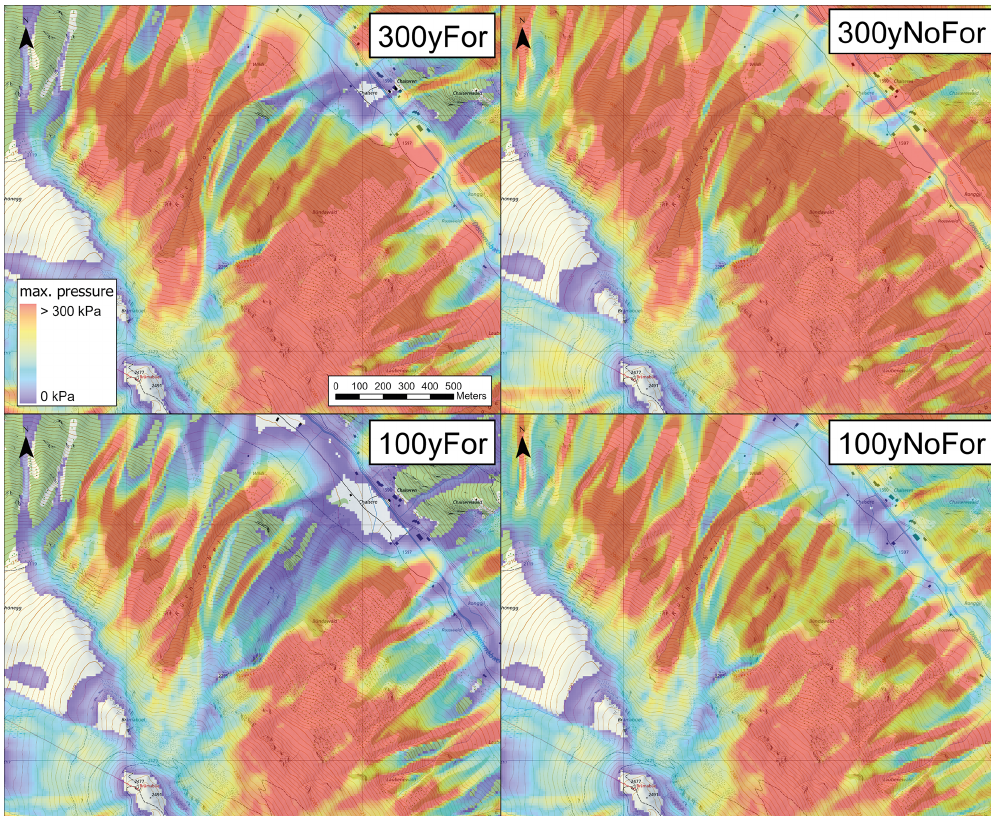
Figure 8. Maximum pressure of the simulated avalanches for the two rare scenarios for the subsection Duchli. The corresponding PRAs are depicted in Fig. 5 (map source: Swiss Federal Office of